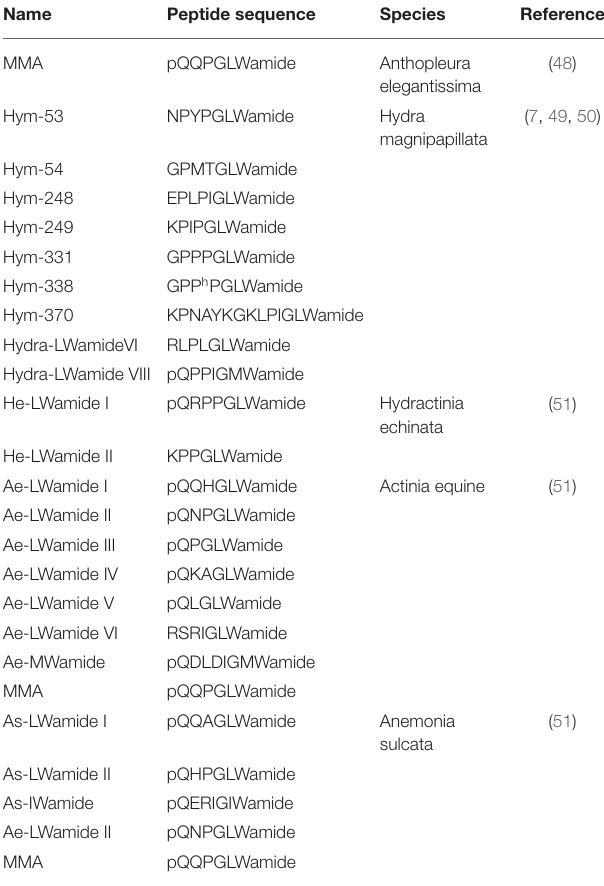
TABLE 2 | GLWamide family peptides in